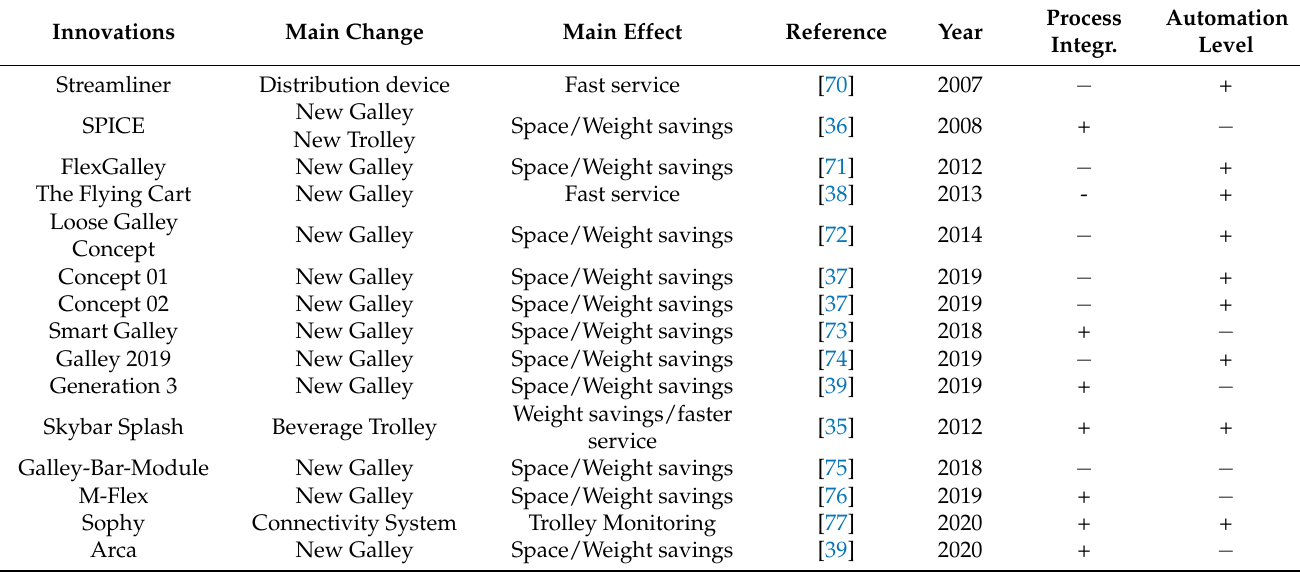
Table A1. Summary state of the art for inflight catering services innovations.